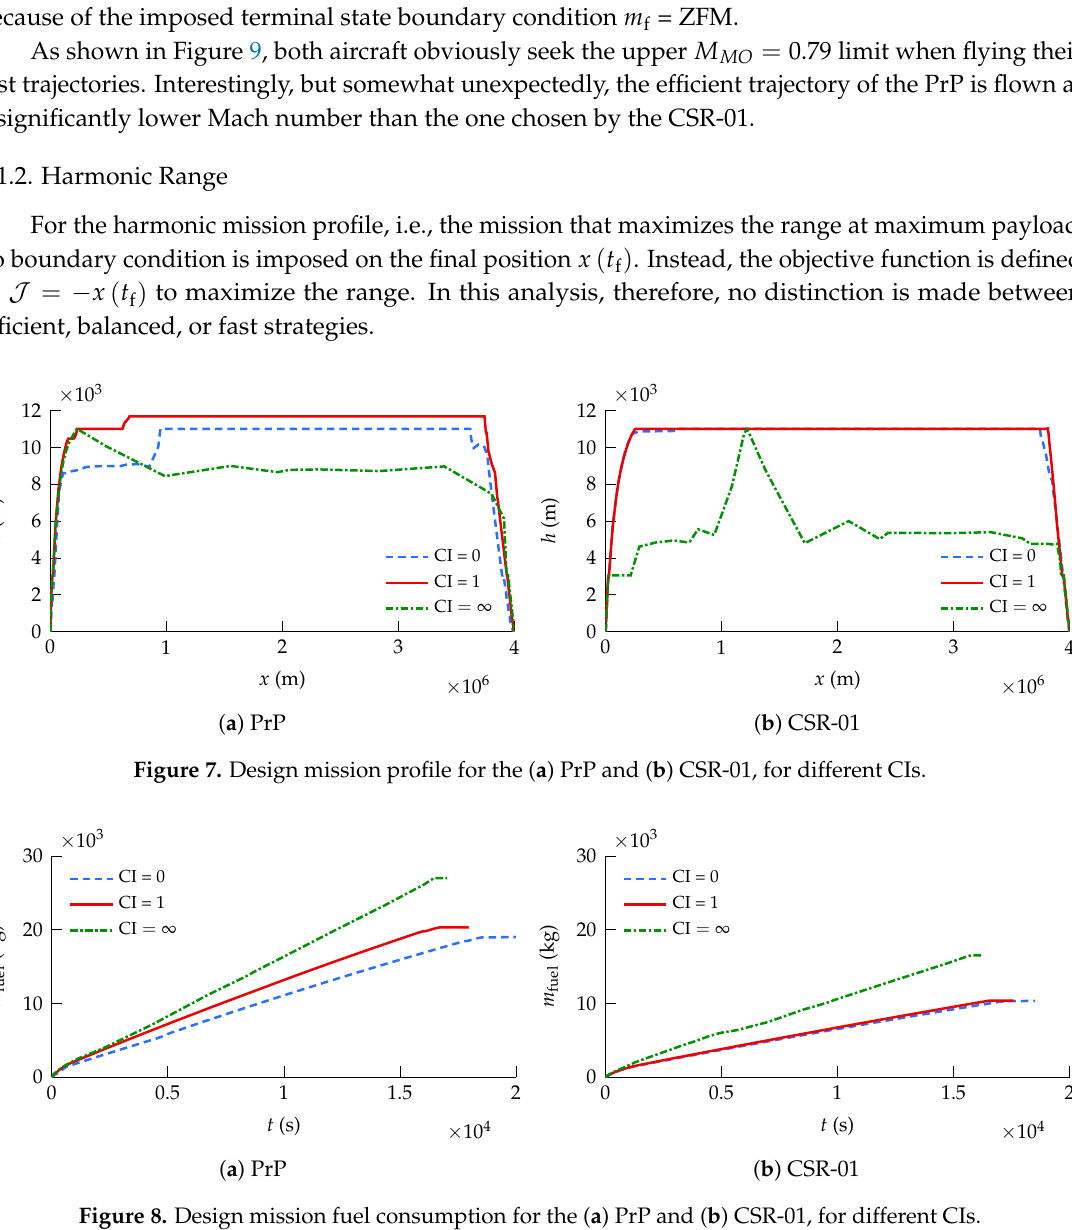
Figure 8. Design mission fuel consumption for the ( a ) PrP and ( b ) CSR-01, for different